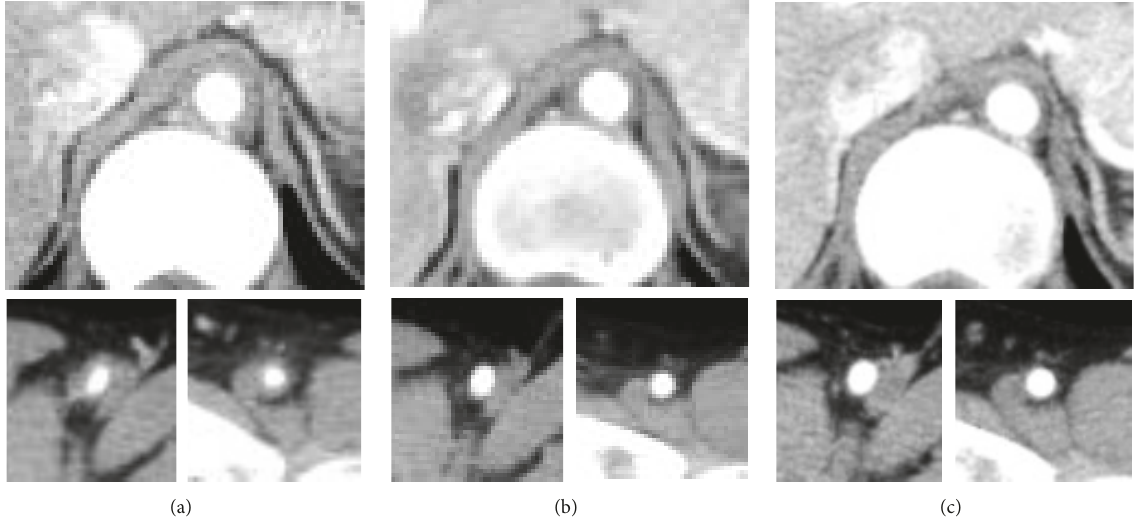
Figure 2: Changes in the computed tomographic findings of arterial lesions of Takayasu arteritis before and after starting tocilizumab therapy. Contrast-enhanced CT of the descending aorta (the upper), the right femoral artery (the bottom left), and the left femoral artery (the bottom right) was performed. Three months before starting tocilizumab therapy, while on the treatment with infliximab, arterial wall thickening of the femoral arteries was observed (a). After six months of tocilizumab therapy, there was a significant decrease in the wall thickness of the descending aorta and the femoral arteries (b). After 17 months of tocilizumab therapy, there was a further decrease in arterial wall thickness and an increase in the intraluminal diameter of the descending aorta and the femoral arteries